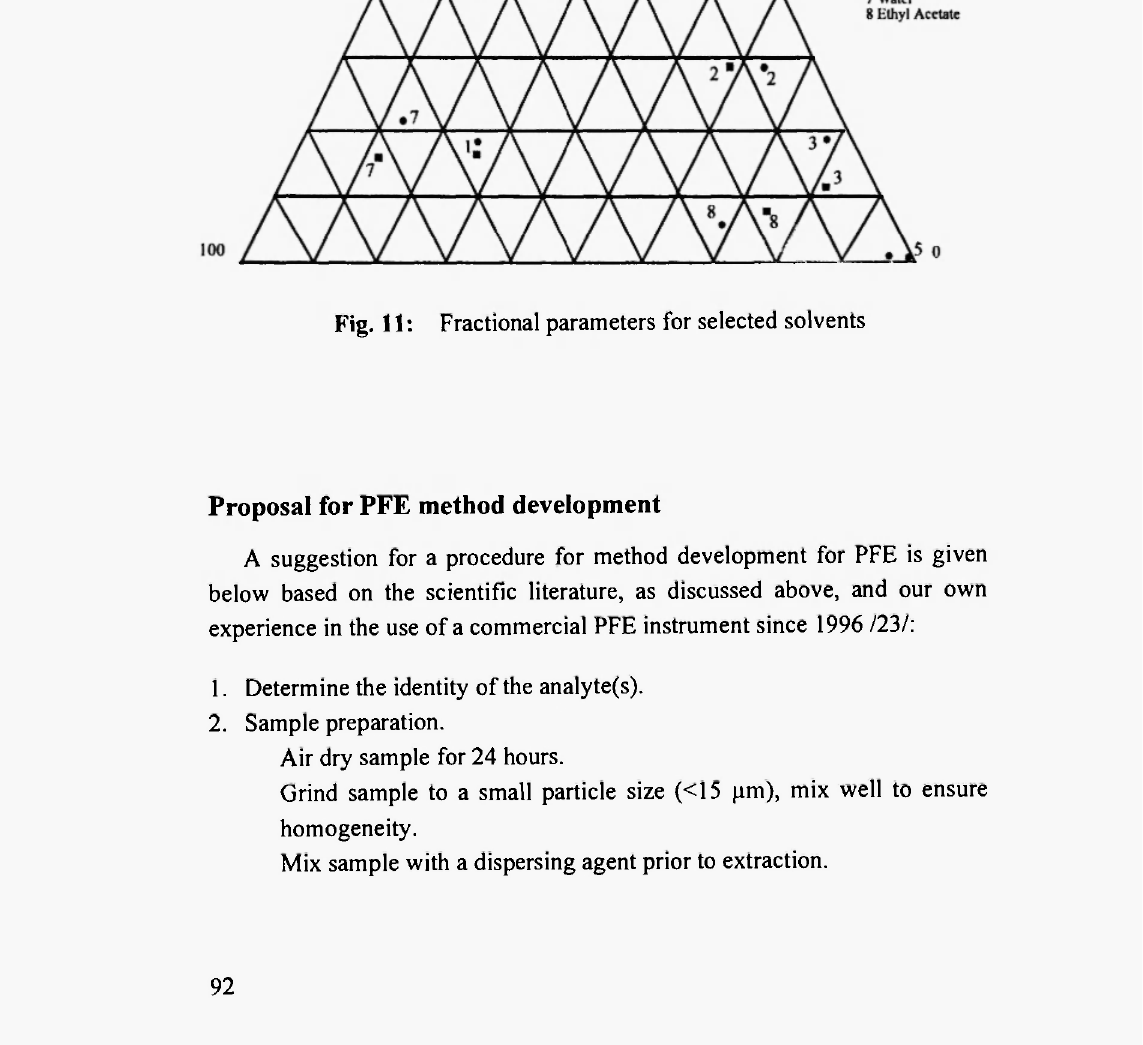
Fig. 11 : Fractional parameters for selected